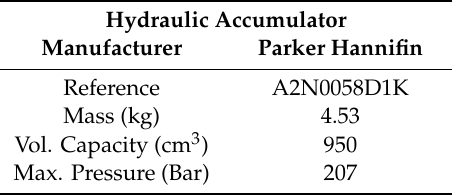
Table 1. Characteristics of the hydraulic accumulator used in this study.